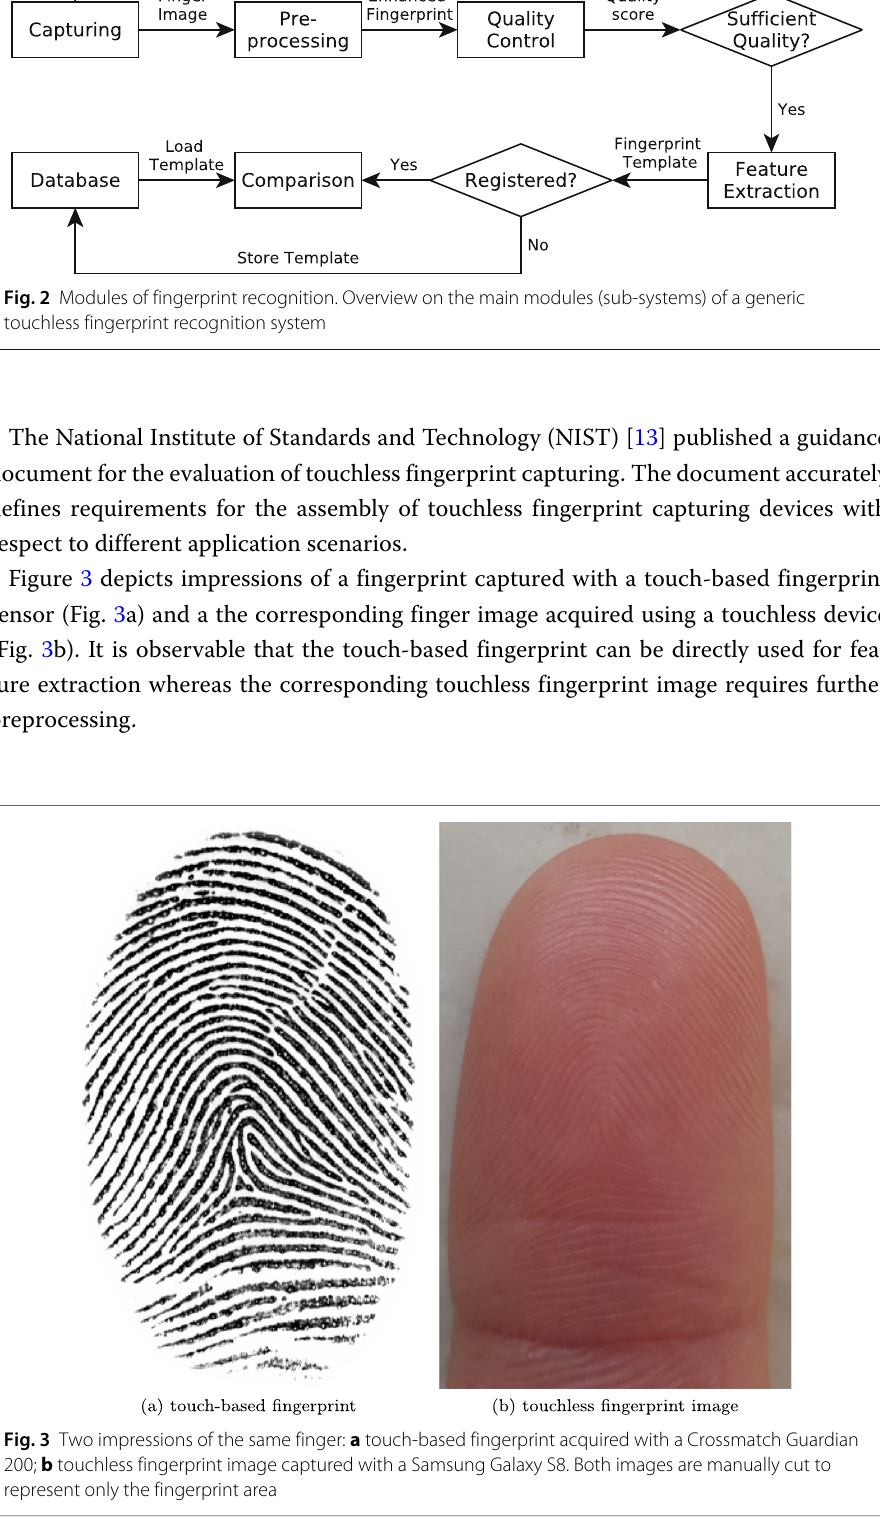
Fig. 3 Two impressions of the same finger: a touch-based fingerprint acquired with a Crossmatch Guardian 200; b touchless fingerprint image captured with a Samsung Galaxy S8. Both images are manually cut to represent only the fingerprint